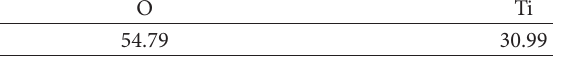
Table 1: The components in the prepared GO-TiO